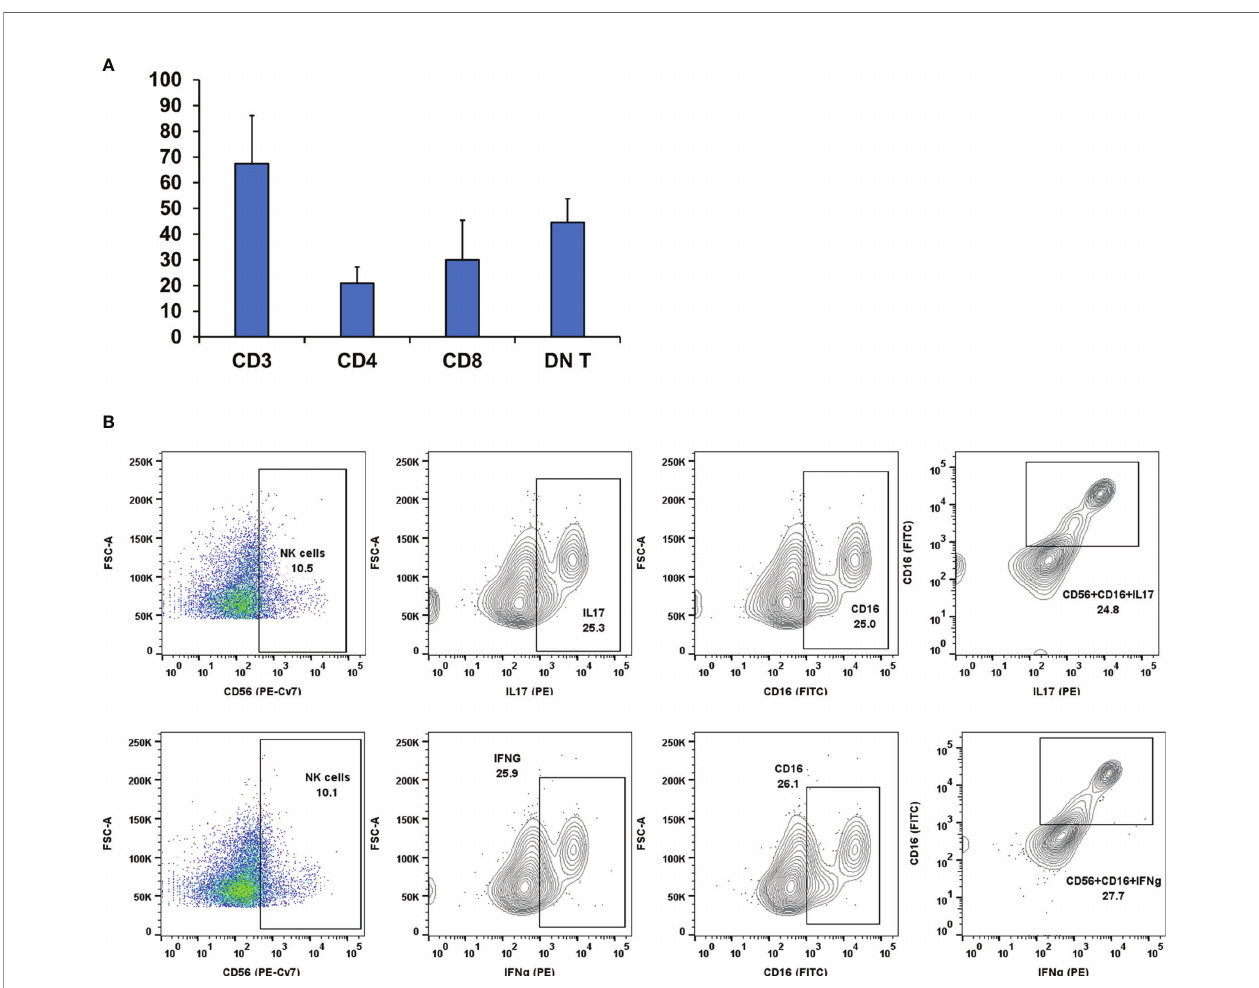
FIGURE 5 | (A) Lymphocyte distribution in Fine Needle Aspiration (FNA) samples. In some samples (n = 4), there was a high CD3 count along with a high DN T-cell count but were non-cancerous. Therefore, we probed the samples for other leukocyte types [i.e., Natural Killer (NK)]. (B) Pseudo-color dot plots of lymphocyte specimens from representative FNA aspirates of patients with background Hashimoto thyroiditis. First specimens were gated for CD3 - and subsequently sorted on the basis of surface staining CD56, CD16, and intracellular staining Interleukin 17 (IL17) ( B , top panels) and Interferon gamma (IFNg) ( B , bottom panels). The fl